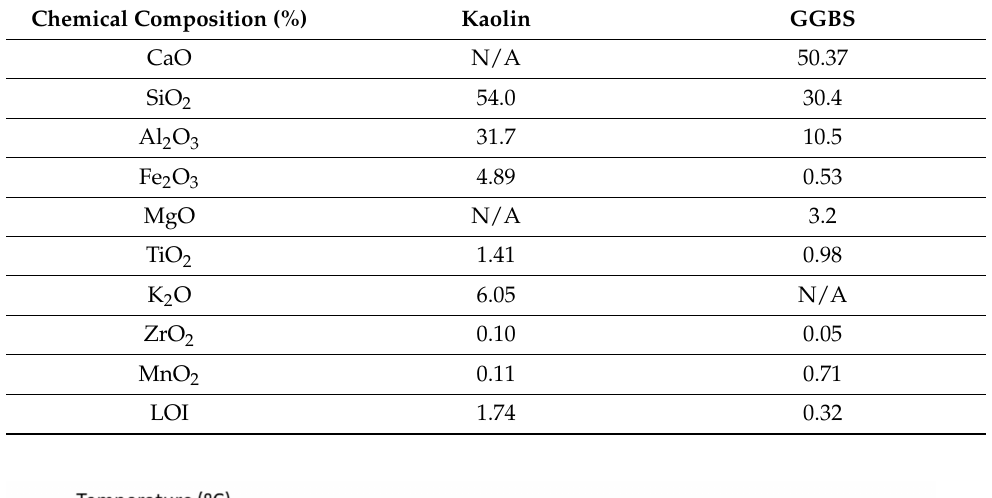
Table 1. Chemical composition of kaolin and ground granulated blast furnace slag (GGBS).